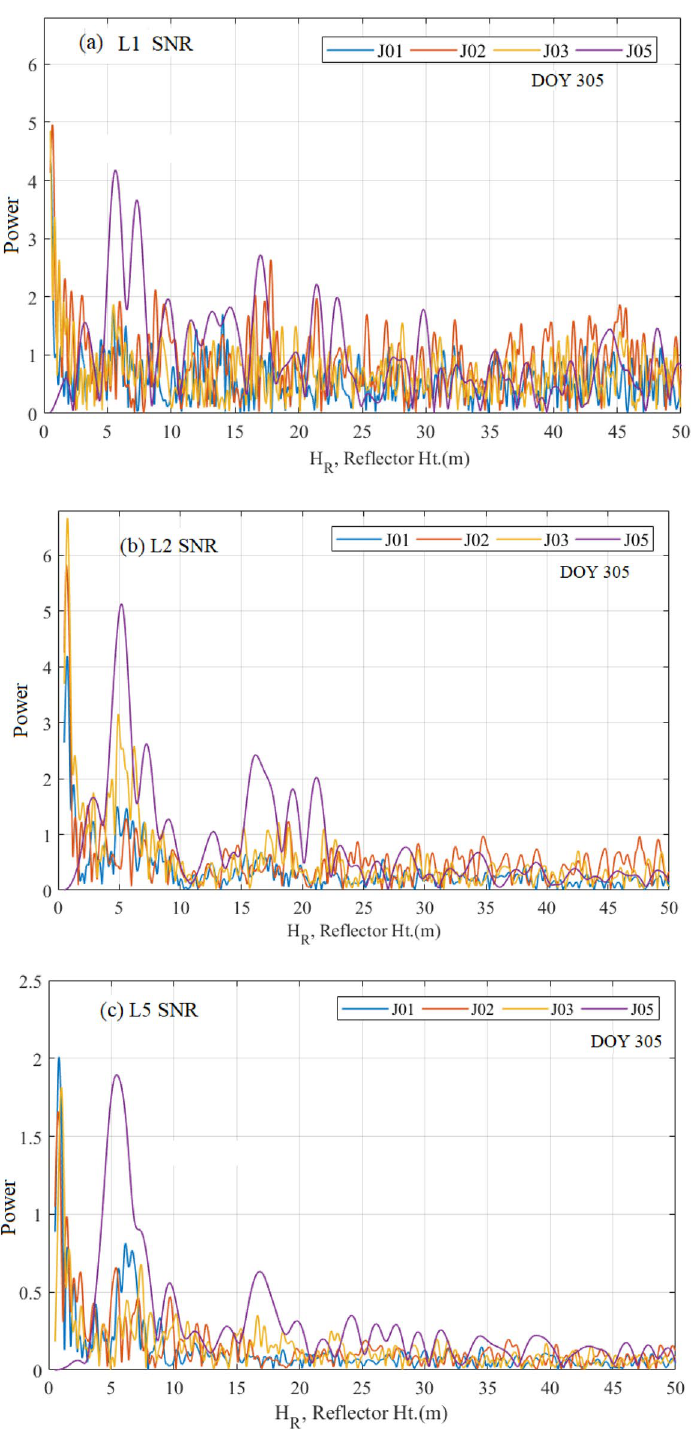
Figure 5. QZSS ( a ) L1 SNR, ( b ) L2 SNR, and ( c ) L5 SNR observations with multipath patterns and LSP for J01, J02, J03 and J05 satellites. Note the H eff is one point on the x-axis and Ht. stands for